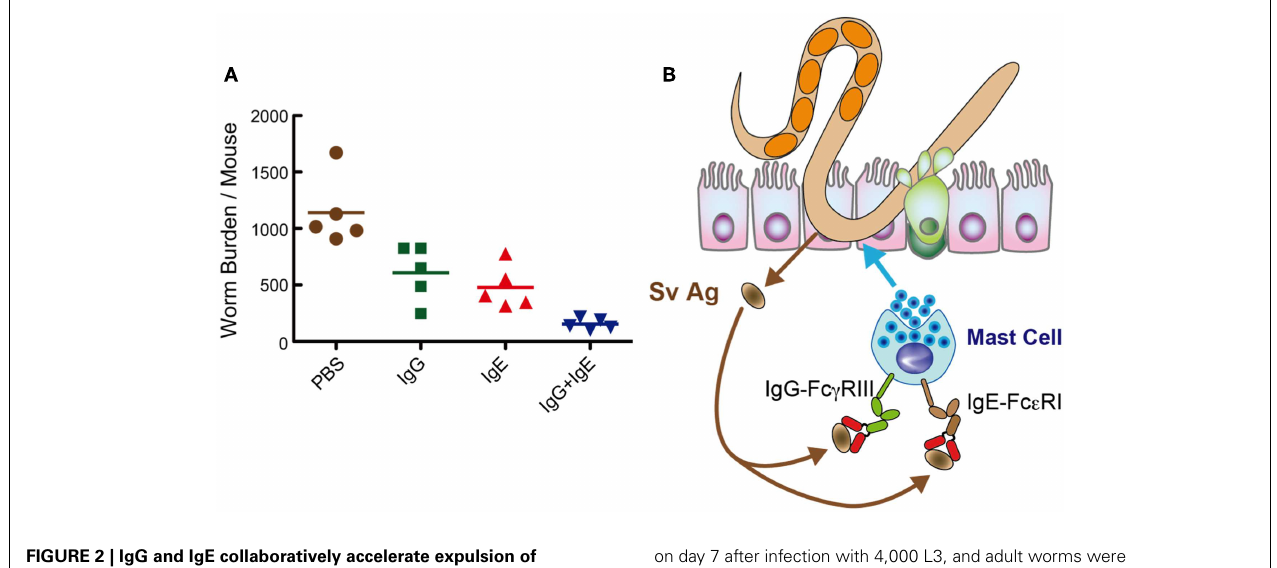
FIGURE 2 | IgG and IgE collaboratively accelerate expulsion of S. venezuelensis infection . (A) To examine which classes of Igs are able to induce worm expulsion.We injected IgG Fr (1.8mg), IgE Fr (5 µ g), or a mixture of IgG Fr (1.8mg) and IgE Fr (5 µ g) into AID − / − mice